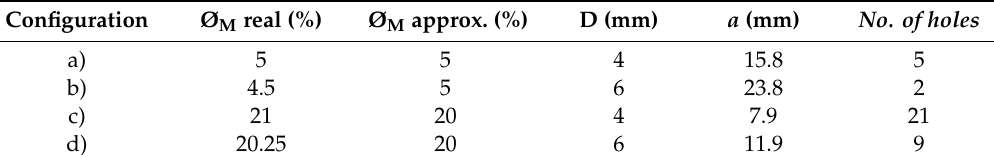
Table 1. Detailed parameters of the four drilling configurations measured Configuration